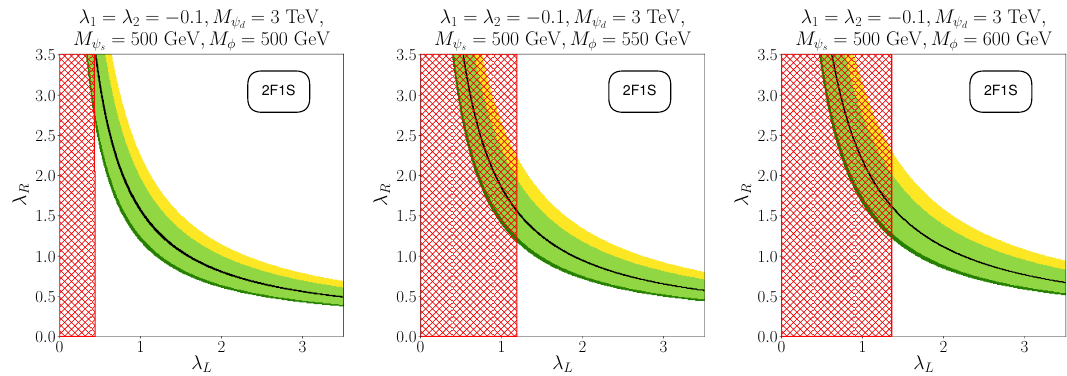
Figure 13. Results from Model 2F1S, scanning over the couplings of the new scalars and fermion to the left- and right-handed muon. Colours are the same as in figure 9. The mixing couplings are fixed to λ = λ = − 0 . 1 . In this scenario the fermion doublet has its mass fixed at M 1 2 GeV, the fermion singlet is fixed at M = 500 GeV, and the scalar doublet has its mass slowly ψ s increased from M . Points below or to the left of the red line produce an over abundance of dark ψ s matter and are strongly